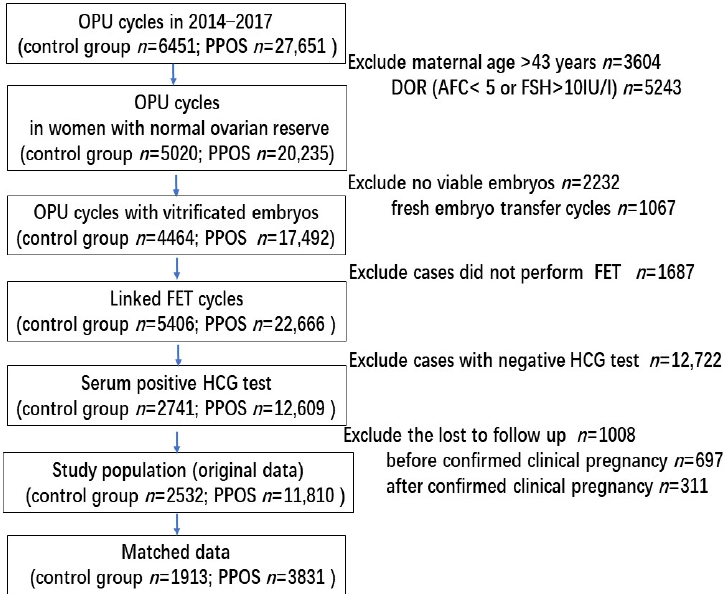
Figure 1. Screening and flow of participants through study.